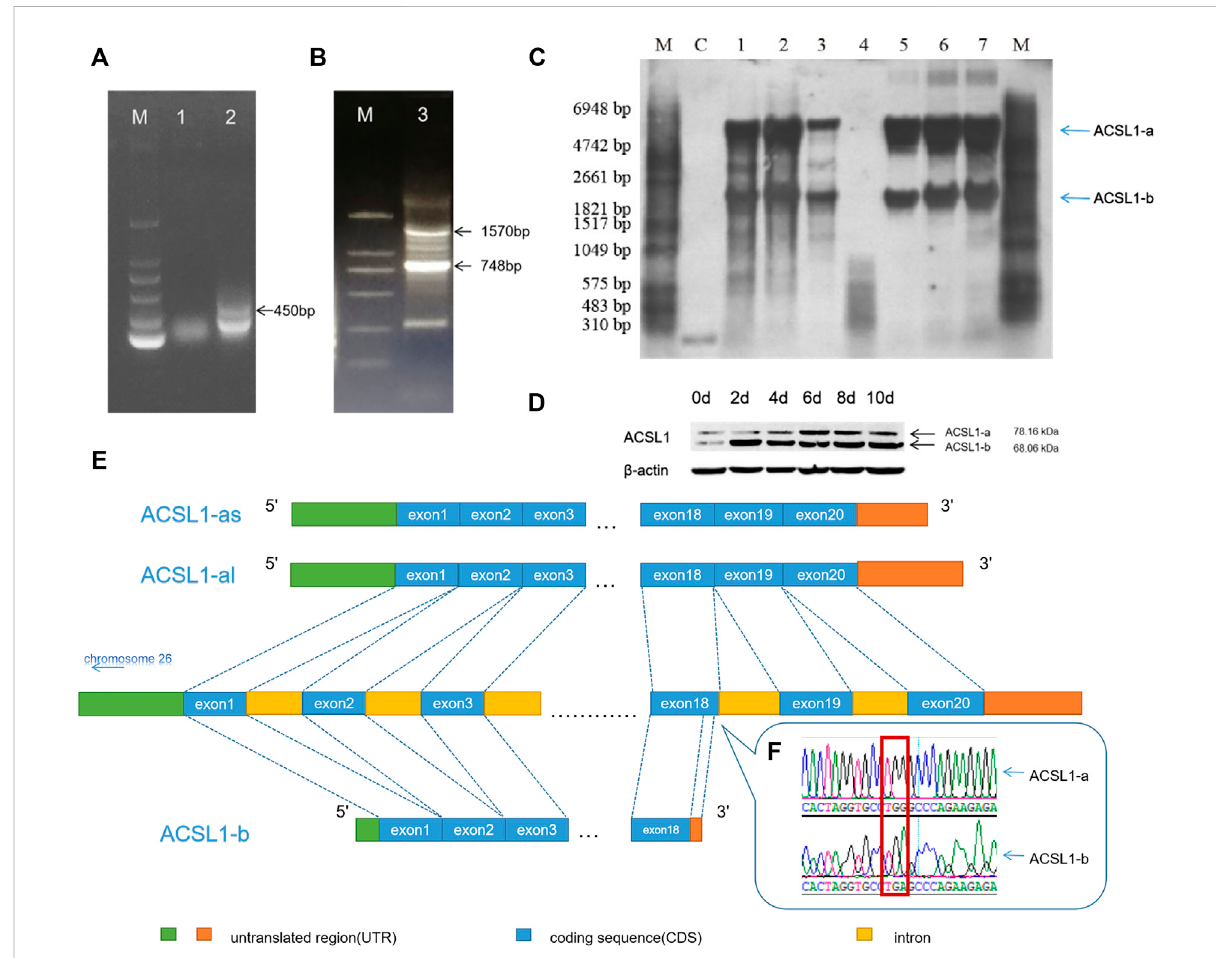
FIGURE 1 (A) 3 ′ RACE PCR result of the sheep ACSL1 gene of SP1 and SP2. (B) 3 ′ RACE PCR result of the sheep ACSL1 gene of SP3 and SP4 (lane M: DL2000 marker; lane 1: 3 ′ RACE by SP1; lane 2: 3 ′ RACE by SP2; lane 3: 3 ′ RACE by SP3 and SP4). (C) Northern blotting results of sheep tissues and adipocytes of different differentiation stages (lane M: RNA molecular weight marker; lane C: positive control; lane 1: heart; lane 2: liver; lane 3: muscle; lane 5: sheep preadipocytes on the day 1 of differentiation; lane 6: sheep preadipocytes on the day 4 of differentiation; lane 7: the induced differentiation of sheep preadipocytes on day 8). (D) Western blotting results of sheep tissues and adipocytes of different differentiation stages (when cells were added to the induction medium, it was taken as day 0). (E) Schematic diagram of different transcripts of the ACSL1 gene. (F) RACE sequencing results of G – A